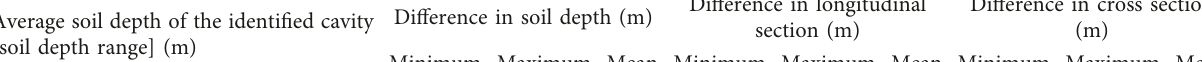
Table 3: Calculation results of mean difference in the scale of the predicted cavity according to the soil depth of the identified cavity. Average soil depth of the identified cavity [soil depth range] (m)